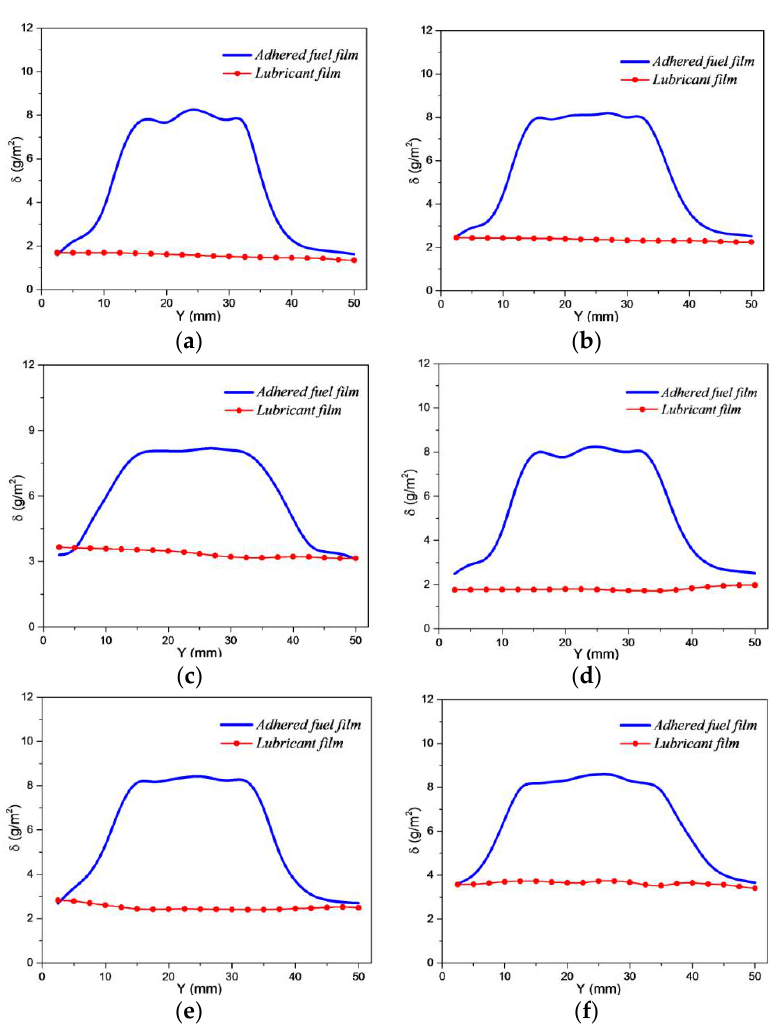
Figure 8. Longitudinal section profiles of adhered fuel film under SWW conditions: ( a – c ) B15 with different lubricant film thicknesses; ( d – f ) B25 with different lubricant film thicknesses.